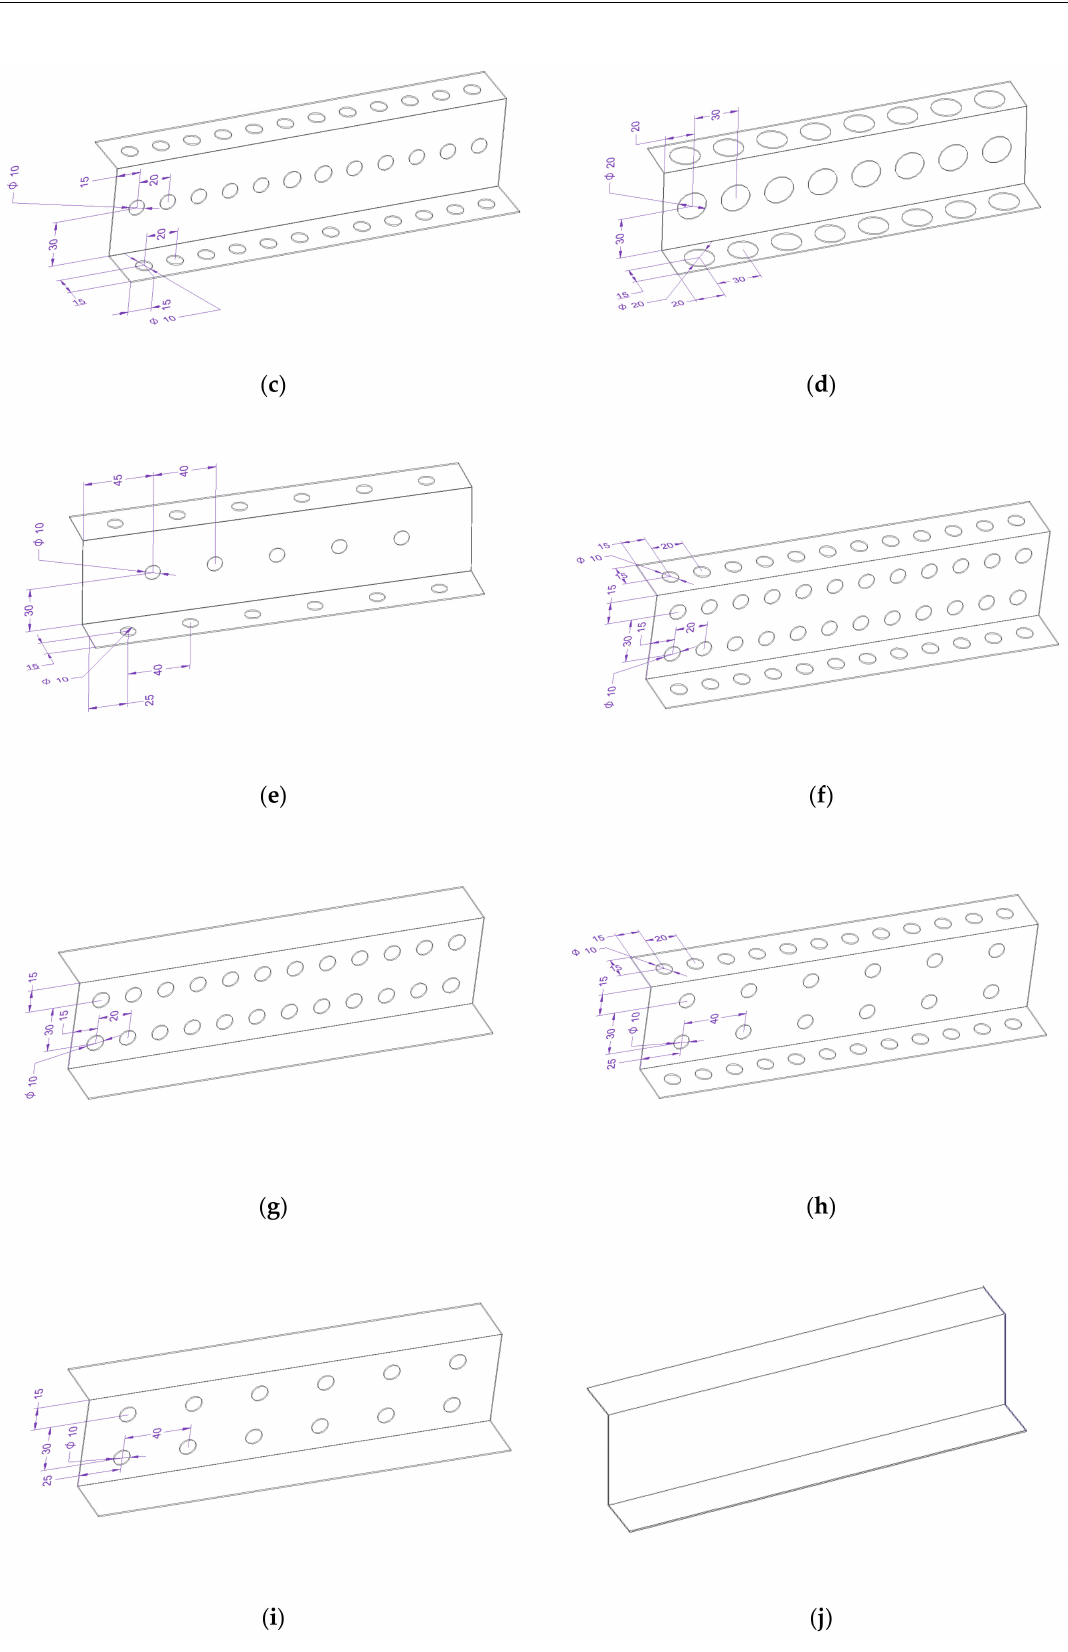
Figure 2. Z-profiles in various cut-out configurations: ( a ) Z1, ( b ) Z2, ( c ) Z3, ( d ) Z4, ( e ) Z5, ( f ) Z6, ( g ) Z7, ( h ) Z8, ( i ) Z9, ( j )